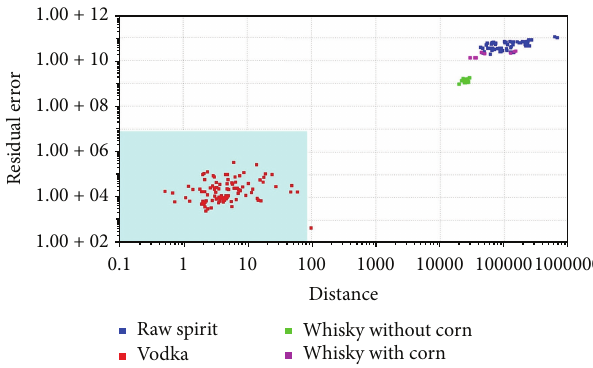
Figure 8: SIMCA analysis for vodkas, whiskies, and raw spirits: whisky with corn, reference group.